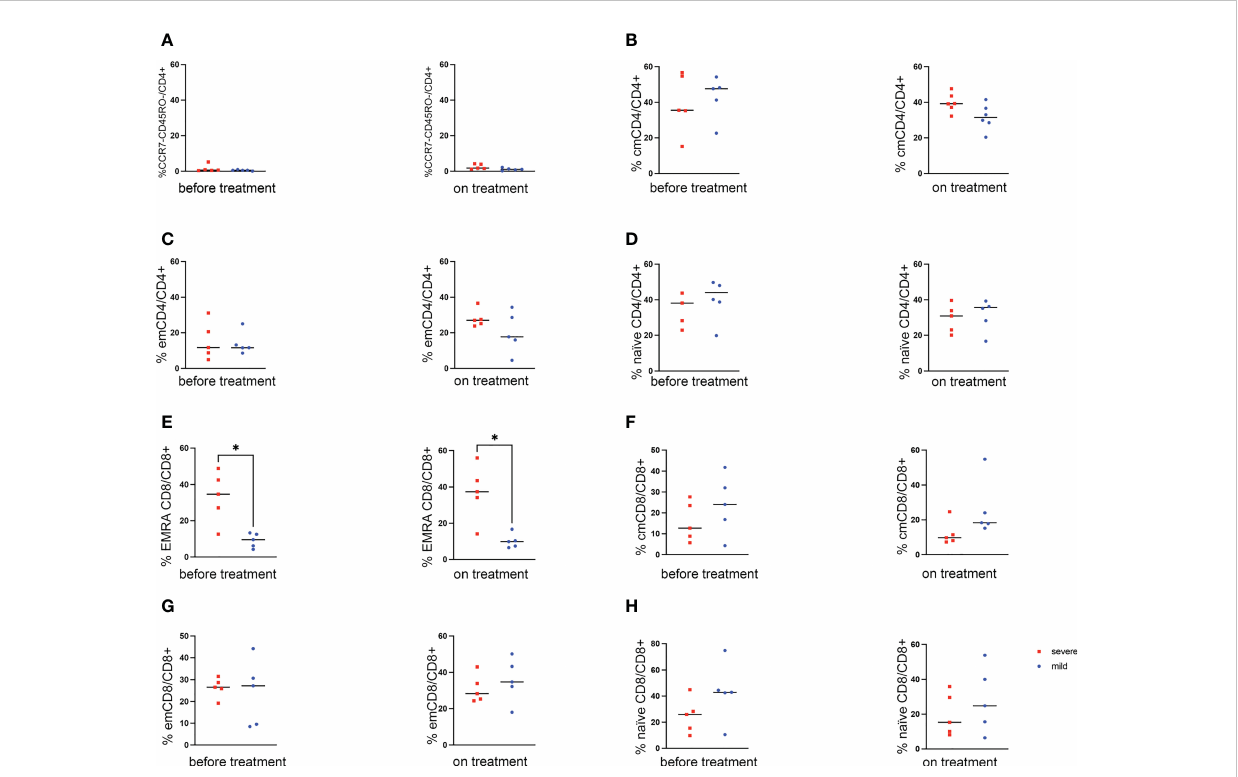
FIGURE 4 Analysis of lymphocyte subpopulations in patients treated with PD-1 and CTLA-4 dual ICB. Comparison of mean percentage of subpopulations of lymphocytes between the two patient groups of cohort 1 (severe vs mild) before the ICB and on treatment. (A – D) CD4 + T cell subpopulations: (A) CD4 + CCR7 - CD45RO - cells. (C) effector memory (em, CD4 + CCR7 - CD45RO + cells). (B) central memory (cm, CD4 + CCR7 + CD45RO + cells). (C) effector memory (em, CD4 + CCR7 - CD45RO + cells). (D) naïve (CD4 + CCR7 + CD45RO - cells). (E – H) CD8 + T cell subpopulations: (E) T EMRA (CD8 + CCR7 - CD45RO - cells). (F) central memory (cm, CD8 + CCR7 + CD45RO + cells). (G) effector memory (em, CD8 + CCR7 - CD45RO + cells). (H) naïve (CD8 + CCR7 + CD45RO - cells). * p<0.05 by T